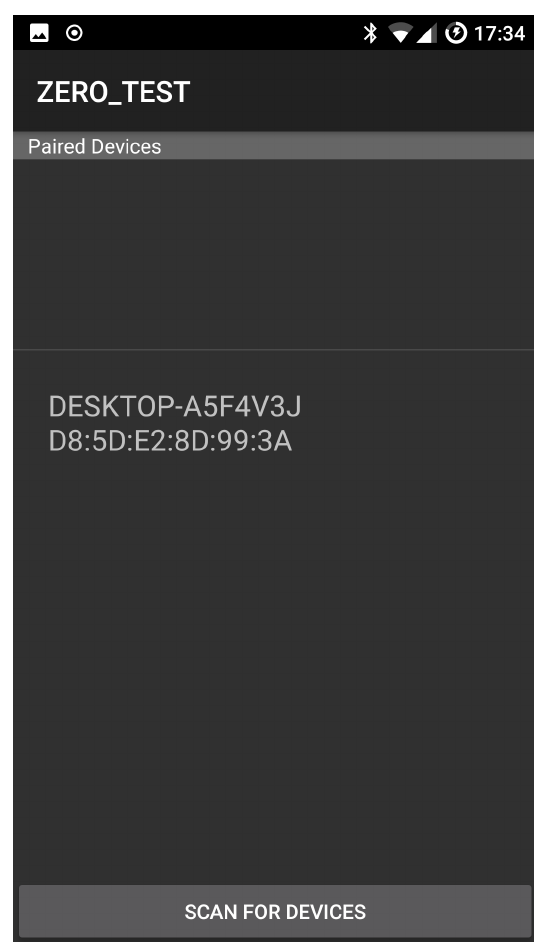
Figure 8. Device